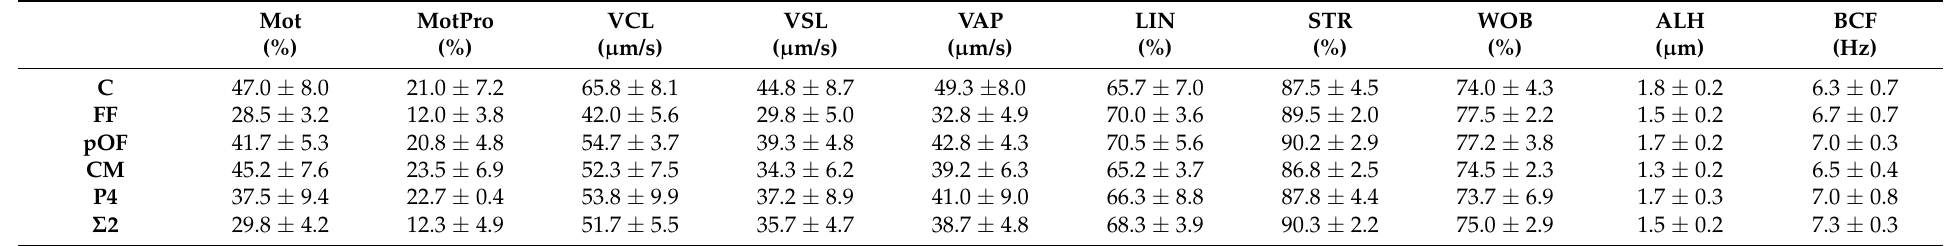
Table 2. Motility of spermatozoa selected by chemotaxis to reproductive biofluids in the chemotaxis system. The effective concentration of chemoattractants were added to well B of the chemotaxis system: Follicular fluid (FF), periovulatory oviductal fluid (pOF), secretions of the cumulus cells (CM), progesterone (P4) and a combination of chemoattractants ( Σ 2 = 1/3 of 0.25% FF + 1/3 of 0.25% pOF + 1/3 of 0.06% CM). Spermatozoa (20 × 10 6 cells/mL) were added to well A, and the system was incubated for 20 min. Motility parameters of